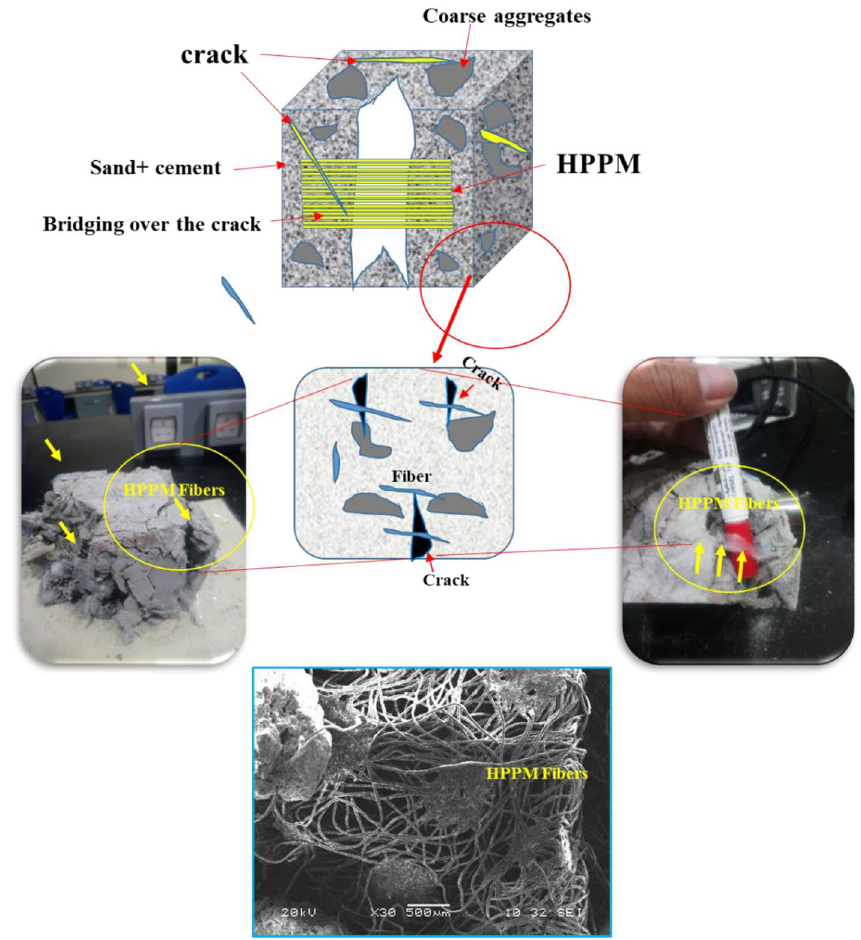
Figure 15. Schematic representation of the mechanism of bridging formed by HPPM at 2% fibers which they acting as. Crack-bridging activity during the